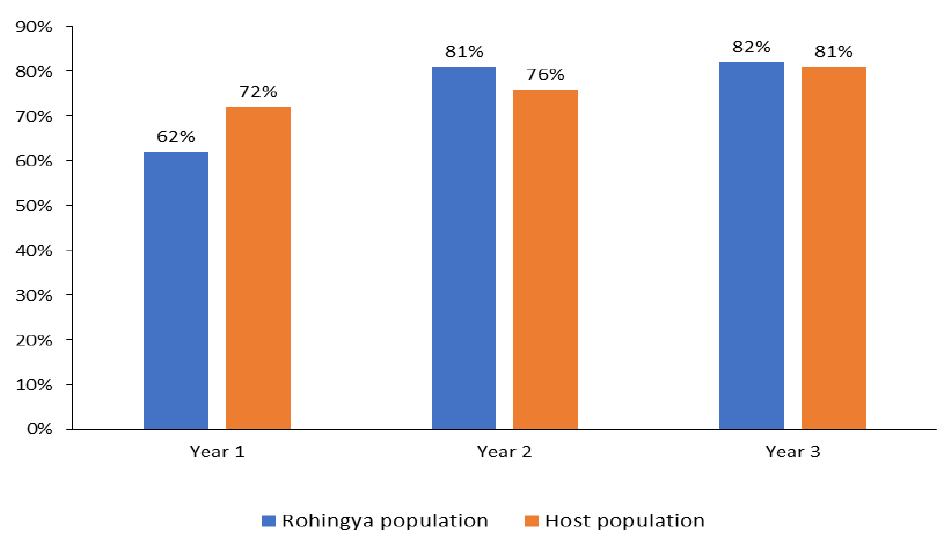
Figure 3. Changing trend of ORS use at home before attending DTCs by the hospitalized Rohingya population and neighborhood host-community population over three years in Teknaf and Ukhia sub-districts, Cox’s Bazar, Bangladesh 2018–2021. Year 1: from 22.04.18 to 31.03.19; year 2: from 01.04.19 to 31.03.20; year 3: from 01.04.20 to 31.03.21. After simultaneous adjustments for covariate handwashing before food preparation in the logistic regression model, age of the Rohingya refugee population care seekers from DTCs, age of 5–14 years (AOR 2.37; 95% CI 1.96–2.85; p < 0.001), age of 15 years and more (AOR 2.39; 95% CI 1.64–3.50; p < 0.001), drinking non-tube well water (AOR 0.42; 95% CI 0.36–0.50; p < 0.001), soap use after using toilet (AOR 2.19; 95% CI 1.47–3.28; p < 0.001), use of